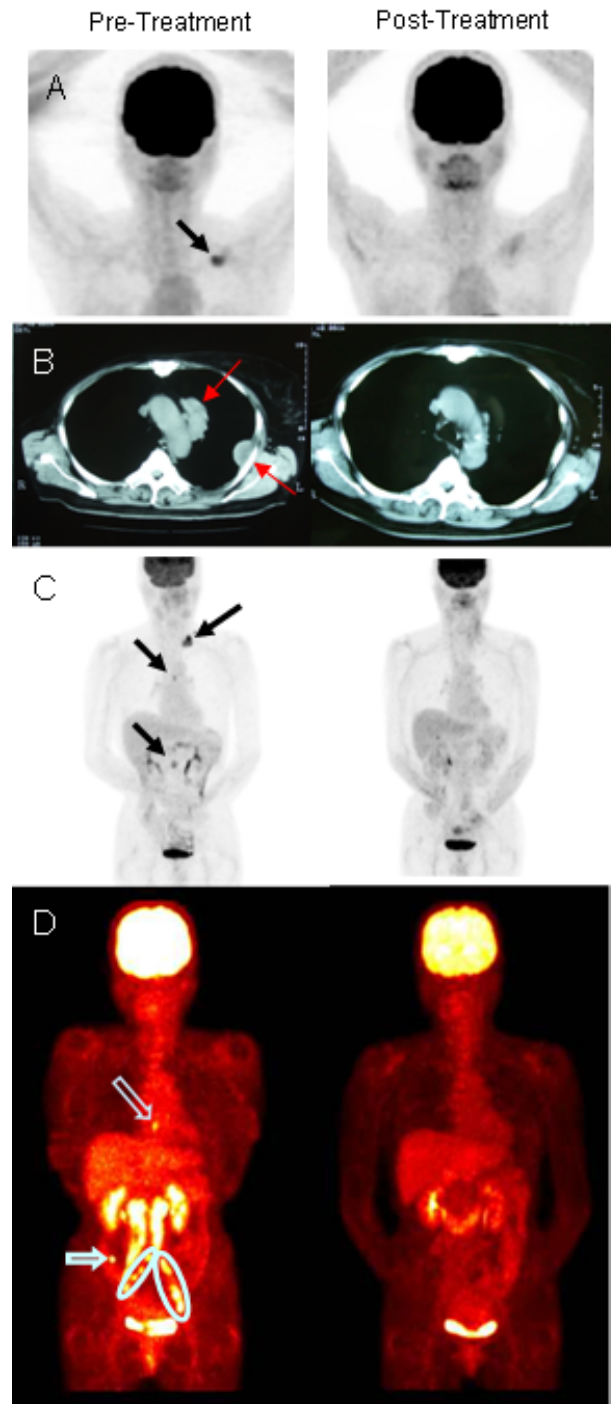
Figure 2. Radiographic evidence of response to treatment. ( A–C ). Computed tomography (CT) radiographs showing metastatic cancer sites (solid arrows) before and after treatment in two breast cancer and one gastric cancer patient, respectively; ( D ). PET-CT showing resolution of treated (circled) and un-treated metastatic sites (open arrows) in a patient with cervical cancer. Circled sites were injected with immature dendritic cells (iDC) followed by intensity modulated radiotherapy (IMRT) as per protocol and resolved as were untreated metastatic lesions (open